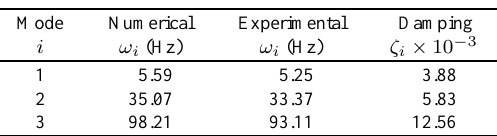
Fig. 12. Scheme of the vibration control experiment. Table 2 First three modes of the cantilever